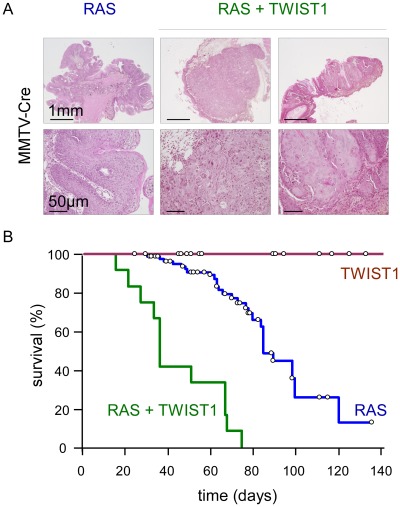
Twist1 promotes tumor progression in vivo.Transgene expression was driven by the MMTV-Cre. While MMTV-Cre; Twist1 mice (TWIST1; n = 71) do not develop skin lesions, MMTV-Cre;K-rasG12D animals (RAS; n = 89) spontaneously develop anal and oral papillomas. In MMTV-Cre;K-rasG12D;Twist1 mice (RAS+TWIST1; n = 19) papillomas evolve into squamous carcinomas. (A) HPS staining of skins either from K-rasG12D or K-rasG12D;Twist1 transgenic mice. Transgene expression is induced by the MMTV-Cre. (B) Kaplan-Meier survival curves of transgenic mice. Survival corresponds to the end point of the experiment, the tumor burden requiring euthanasia of the animal. Open circles indicate mice censored from the dataset.